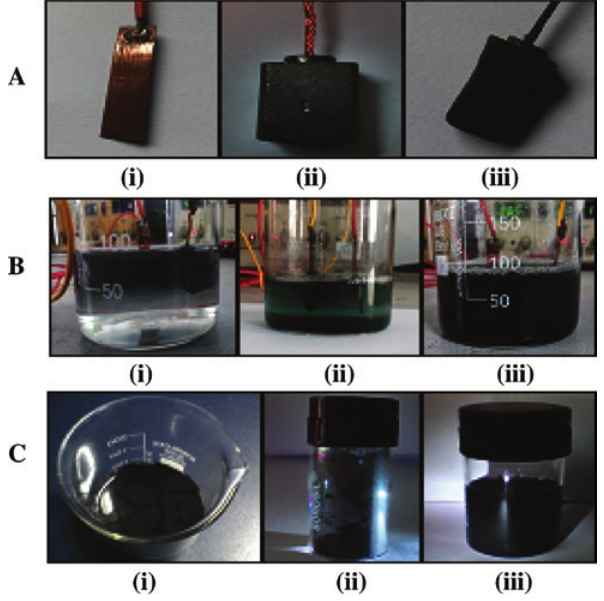
Figure 2: Experimental work of electrochemical exfoliation method. (A) Optical images of (i) copper plate (1 × 10 mm × 15 mm), (ii) carbon block (6.5 × 13.5 × 16 mm), and (iii) carbon block after